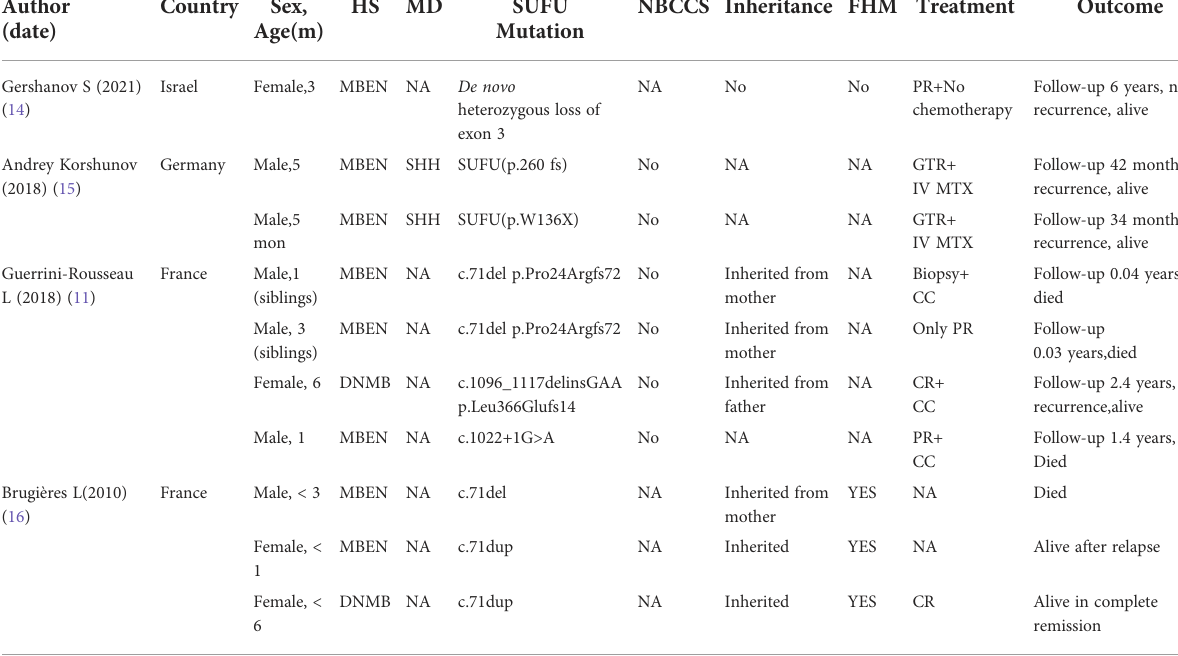
TABLE 2 Summary of the past reported case series of germline SUFU-mutated medulloblastoma in patients younger than 6 months of